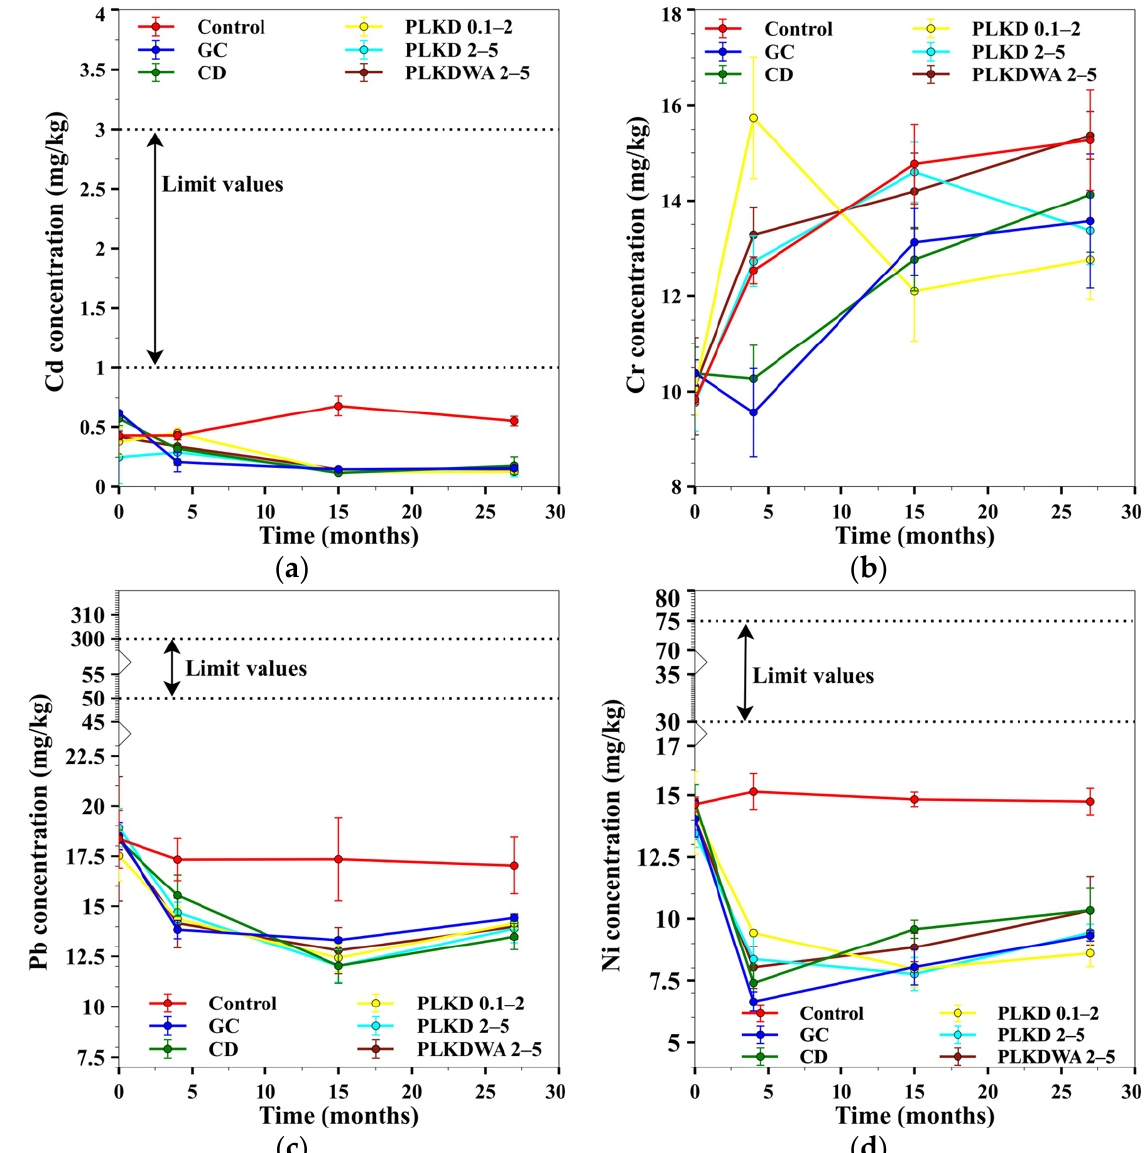
Figure 8. ( a ) Total Cd, ( b ) Cr, ( c ) Pb, and ( d ) Ni concentrations in the soil during the liming experiment. Regulatory limit values according to the EU Commission [74] standards are also